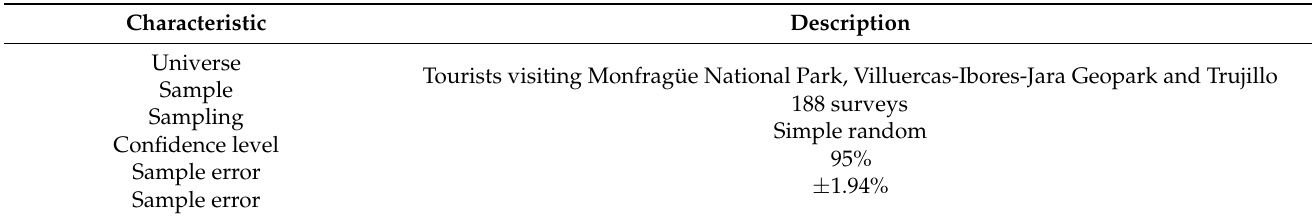
Table 6. Technical sheet of the survey designed for tourists.